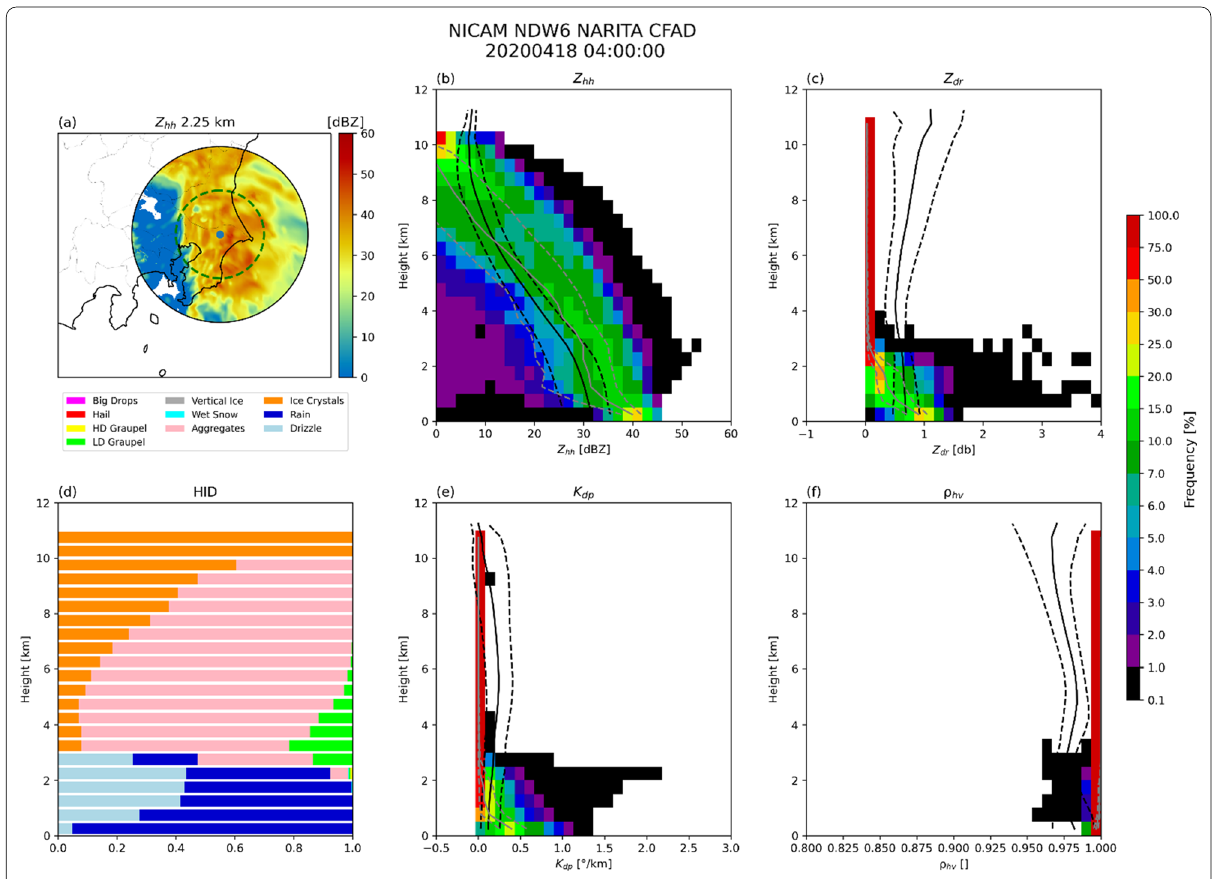
Fig. 16 The same as Fig. 15, but for the NICAM-NDW6